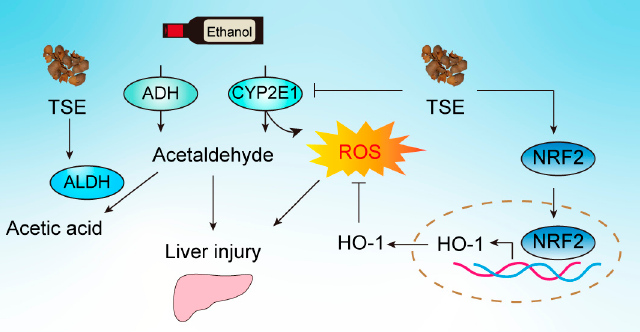
Figure 8. A schematic illustration of tamarind shell extract against ethanol-induced liver damage. Tamarind shell extract can improve alcohol-induced liver injury by improving alcohol metabolism and activating NRF2 pathway to inhibit oxidative stress.